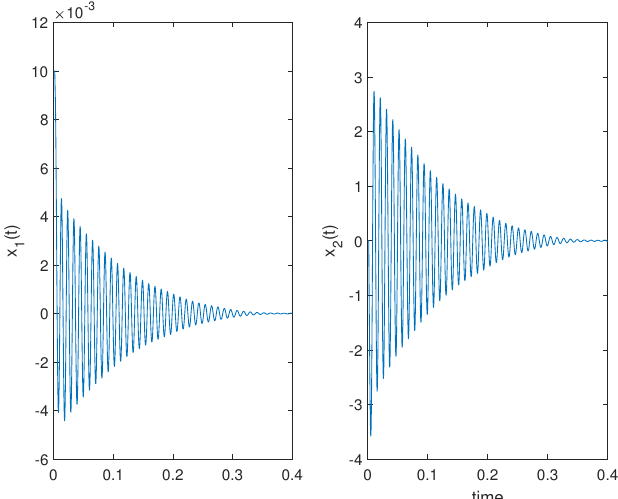
Figure 3. State trajectories of the state vector X ( t ) of Case 1.